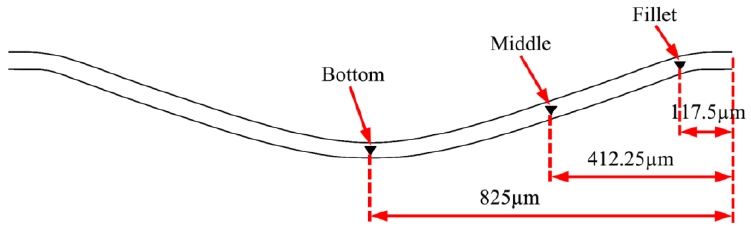
Figure 12. The location of nanoindentation test points.